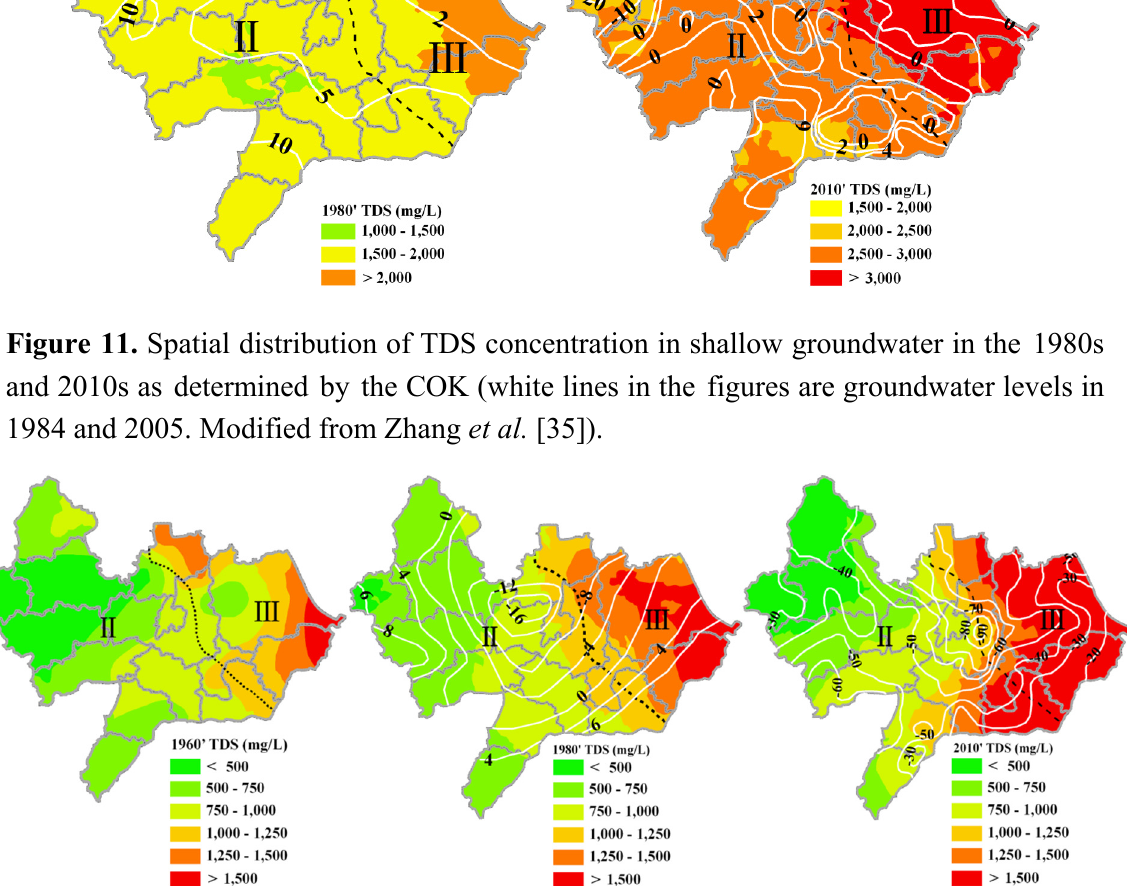
Figure 12. Spatial distribution of TDS concentrations in deep groundwater in the 1960s, 1980s and 2010s as determined by the COK (white lines in the figures are groundwater levels in 1980 and 2005. Modified from Zhang et al.